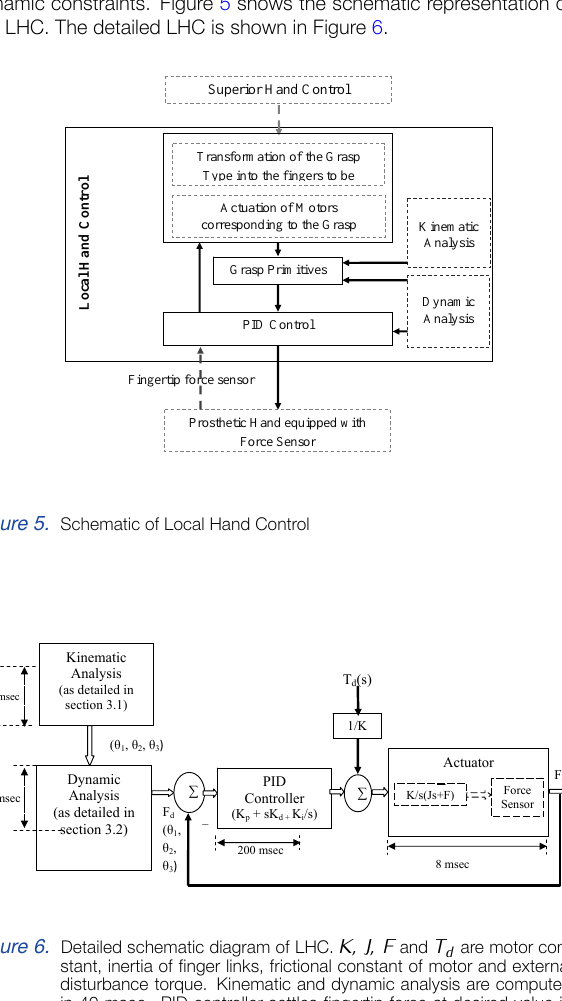
Figure 6. Detailed schematic diagram of LHC. K, J, F and T d are motor con- stant, inertia of finger links, frictional constant of motor and external disturbance torque. Kinematic and dynamic analysis are computed in 40 msec., PID controller settles fingertip force at desired value in 200 msec. and actuator outputs the desired force at the fingertip in 8 msec.